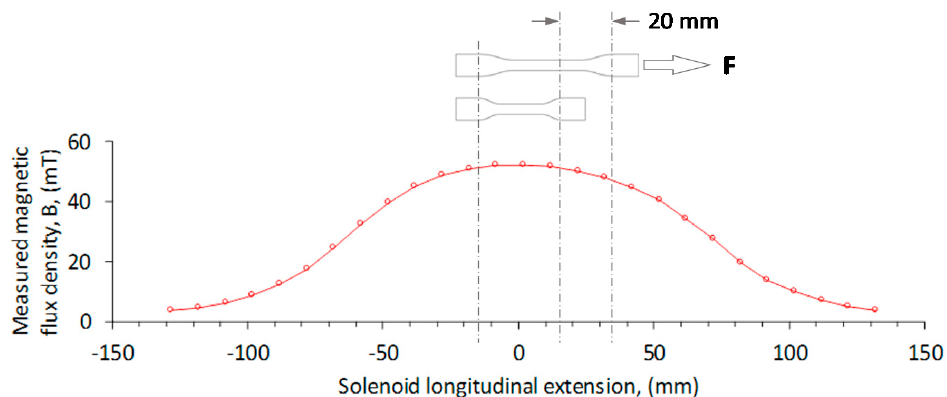
Figure 18. Magnetic flux intensity applied to the specimen inside the solenoid during cyclic loading–unloading tensile tests. F is the tensile force applied during the test.